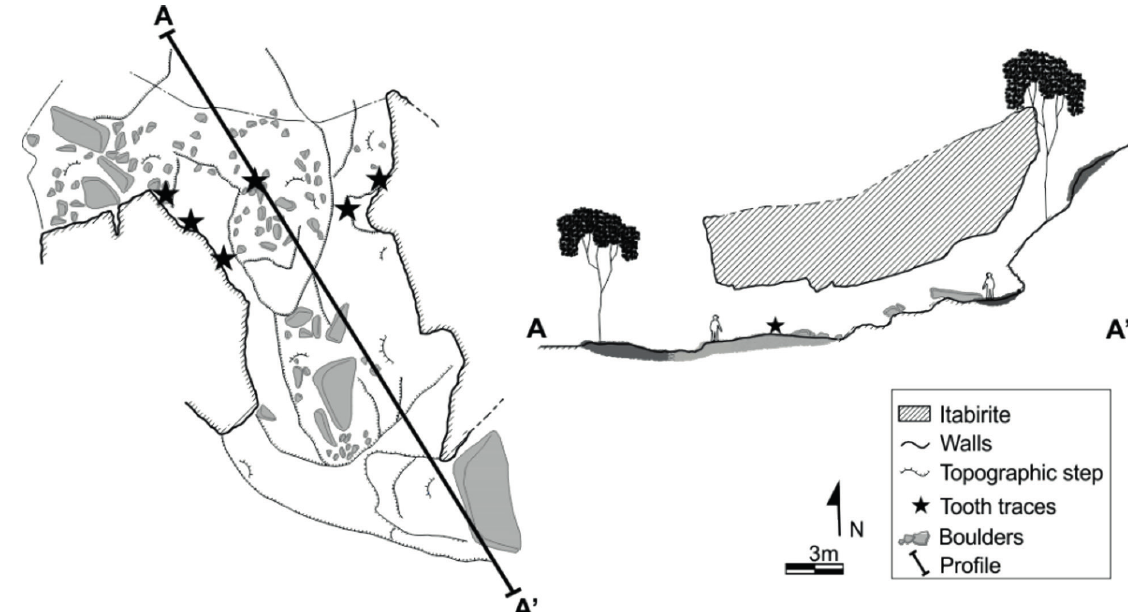
Figure 2 - CMN-0022 cave map and profile showing trace sites. Survey by Carste Ciência e Meio